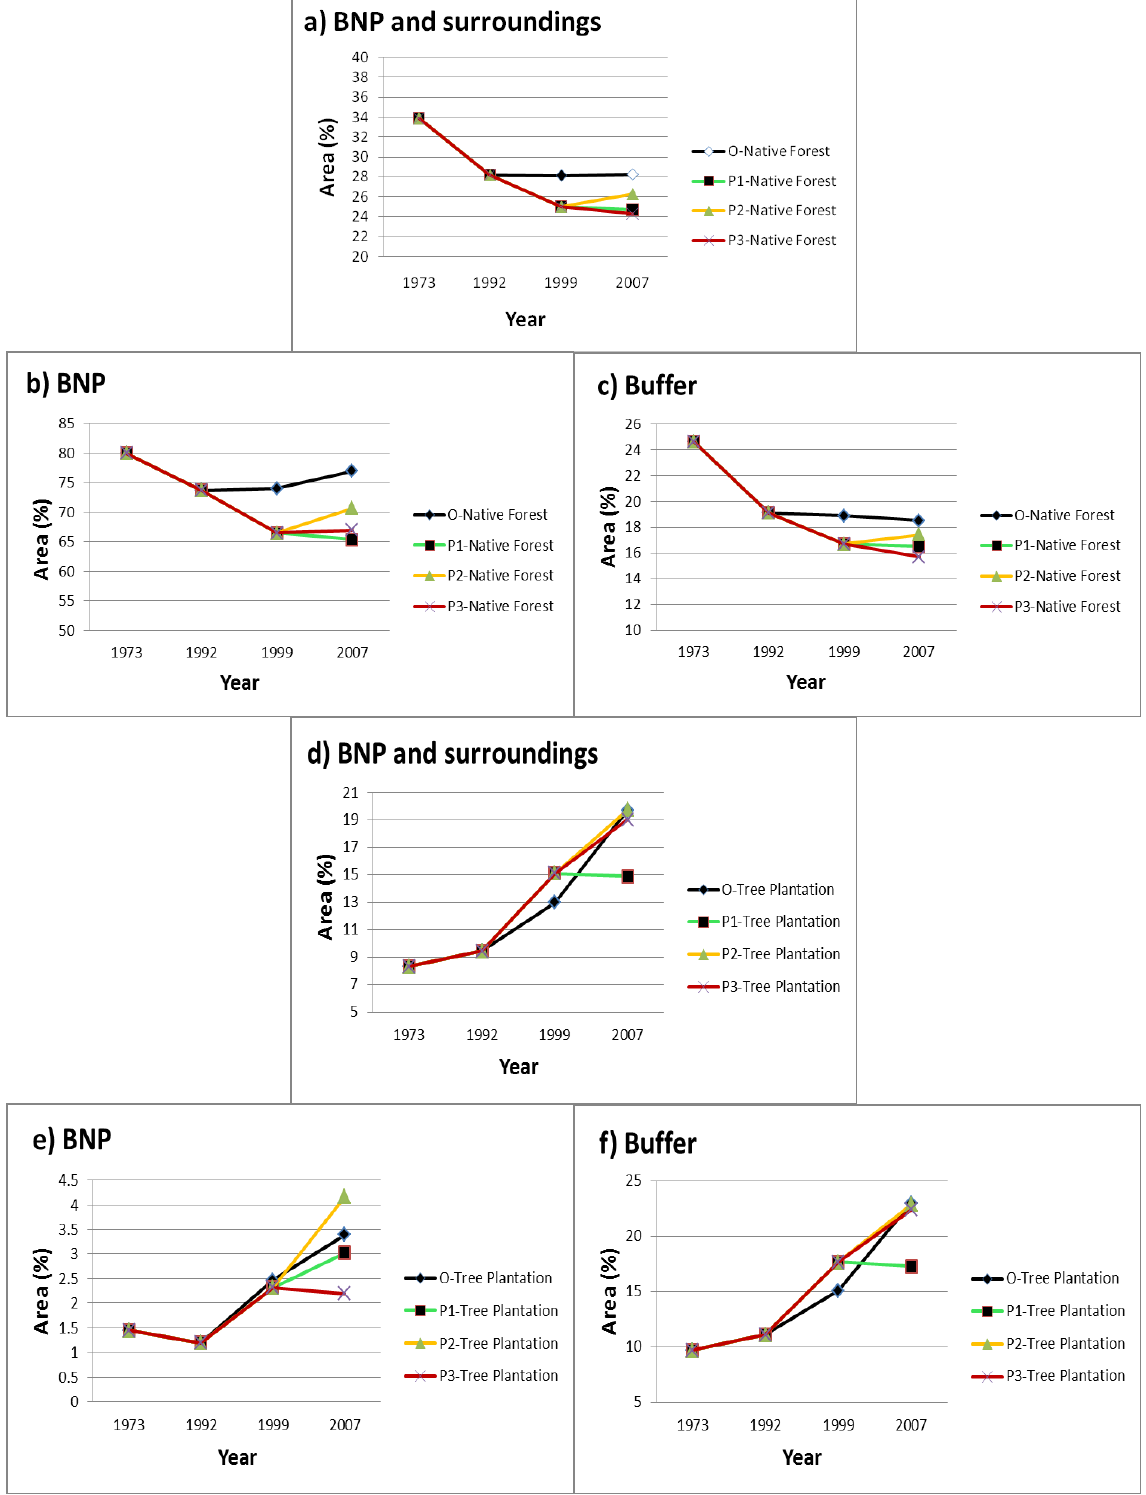
Figure 5. Observed and predicted land covers of from 1973 to 2007 for the overall landscape (total area = 629.82 km 2 ), BNP (total area = 105.48 km 2 ), and the buffer area (total area = 524.34 km 2 ), showing changes in Native forest: ( a – c ), Tree Plantation: ( d – f ) and Non-Forest: ( g – i ). O = Observed land cover, P = Predicted land